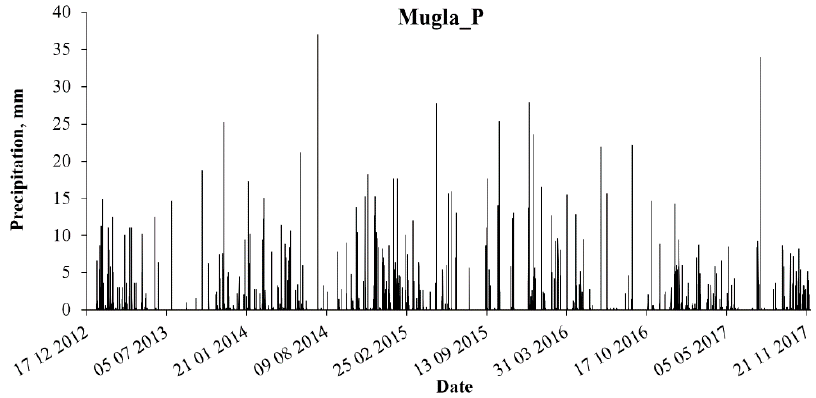
Figure 5. Mugla weather station precipitation data.